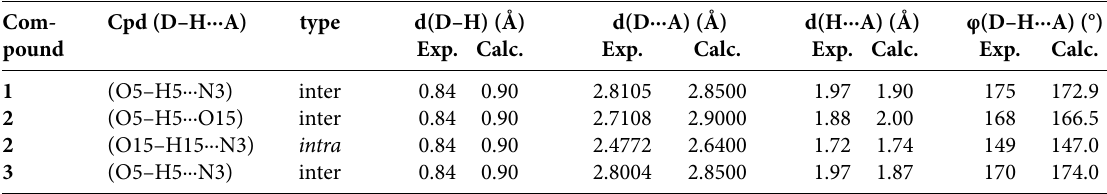
Table 2. Selected distances and angles